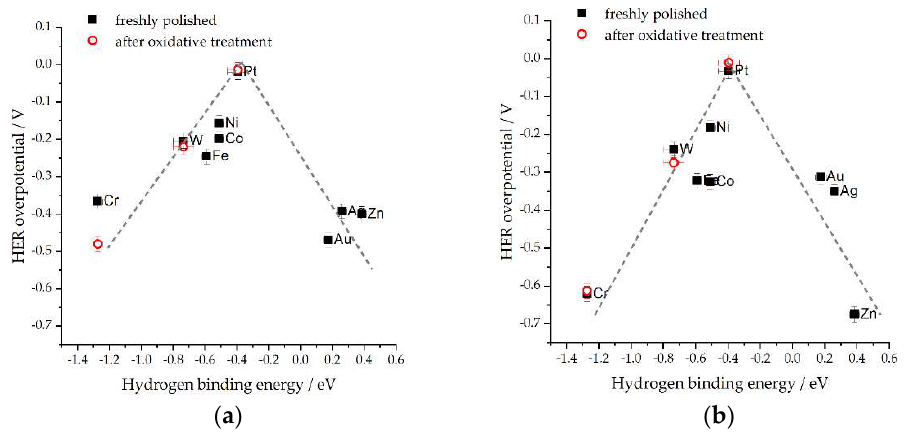
Figure 1. The HER volcanoes in acidic media: ( a ) 0.1 mol dm −3 HClO 4 ; ( b ) 0.1 mol dm −3 HCl. Squares represent freshly polished electrodes, while circles are for the electrodes after oxidative treatment.